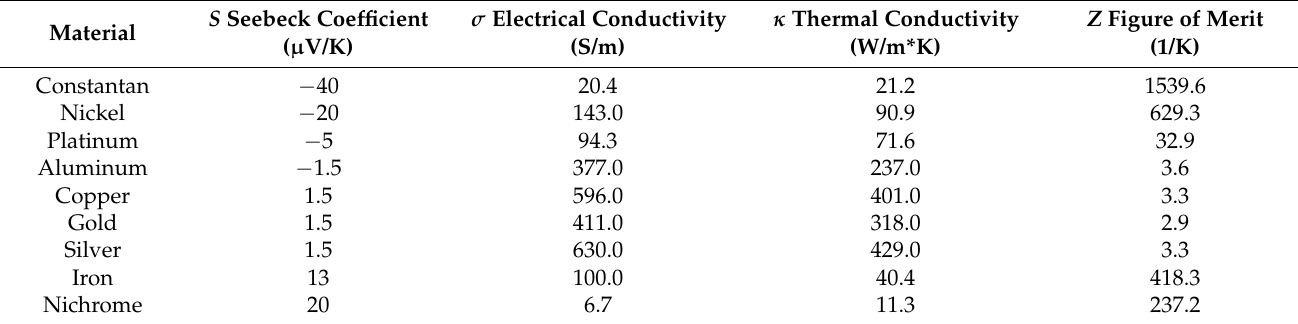
Table 1. Calculation of the figure of merit, using the given